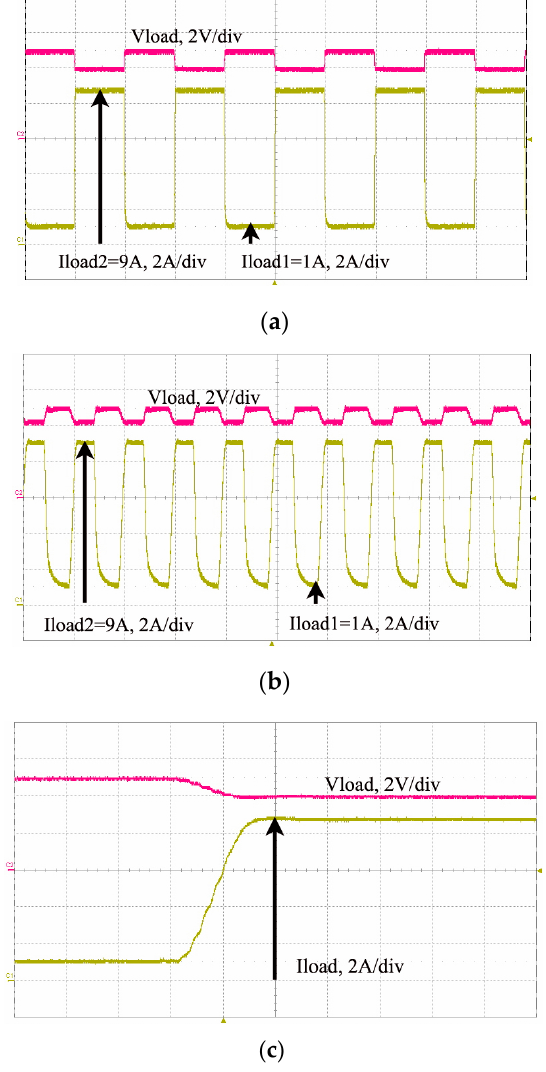
Figure 20. Pulse current sink mode ( a ) 50 Hz pulse current test (10 ms/div), ( b ) 500 Hz pulse current test (2 ms/div), ( c ) step response (200 μ s/div).